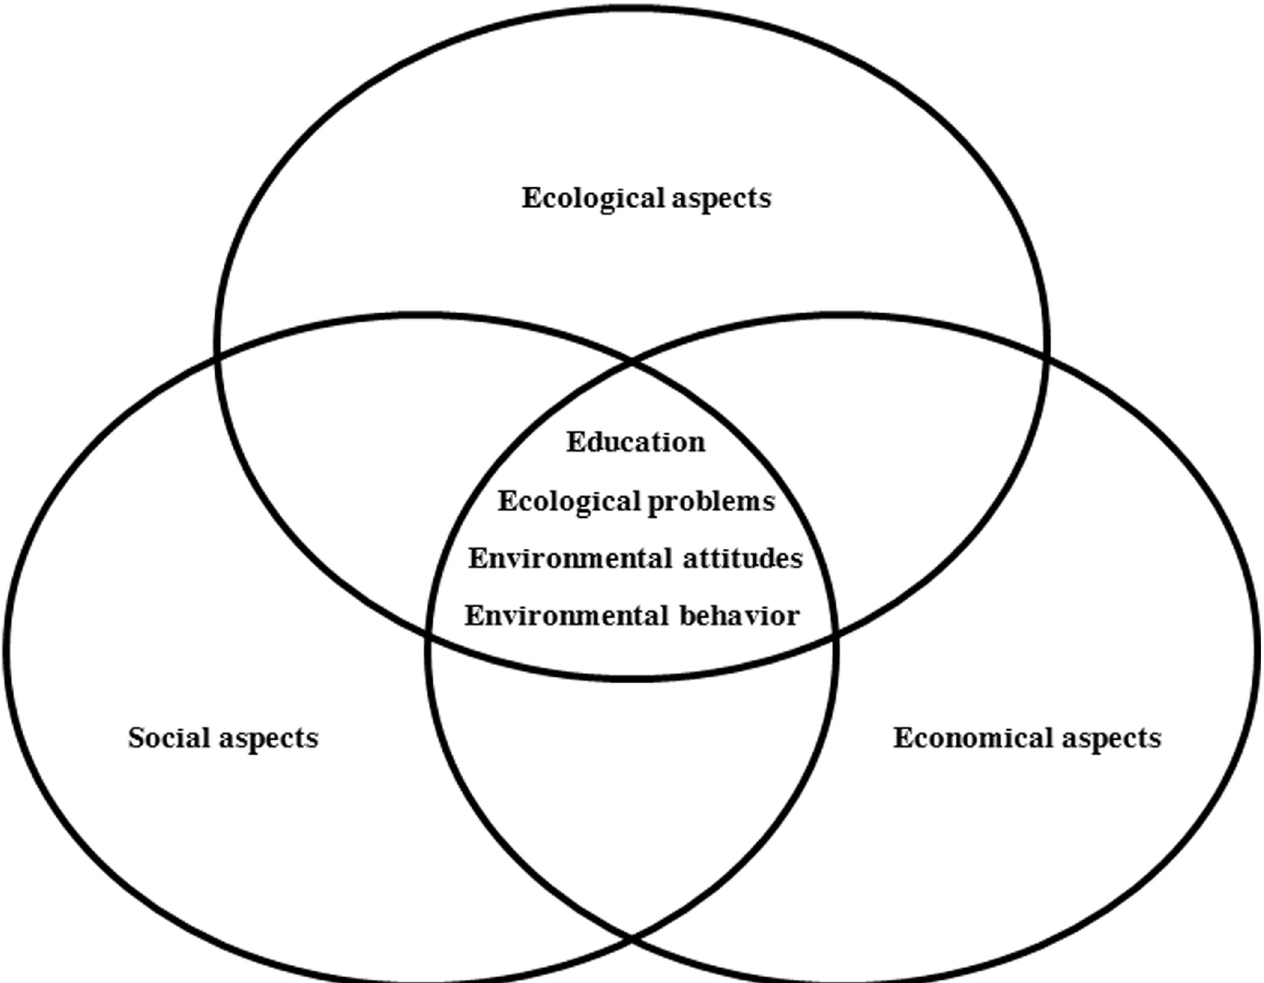
Fig 1. Categories of Environment Education and Education for Sustainable